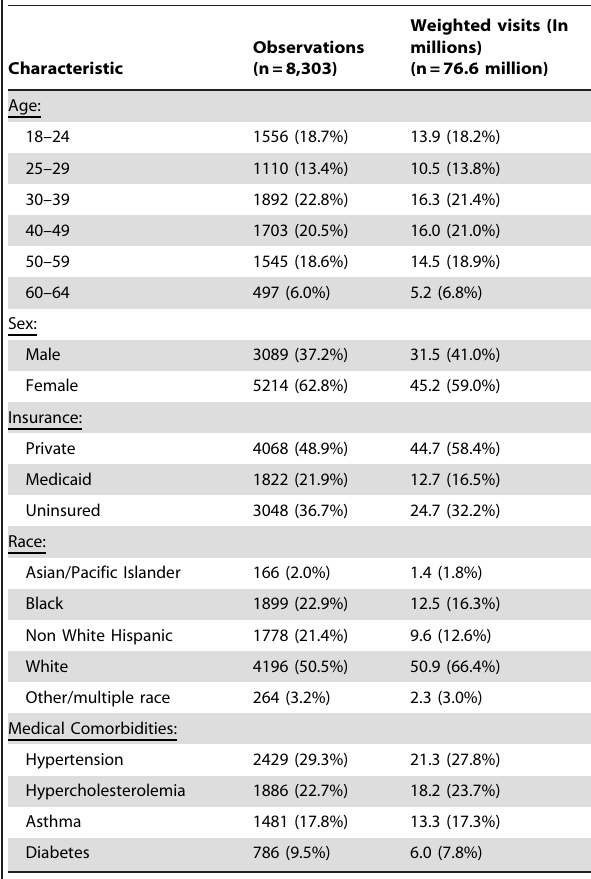
Table 1. Patient demographics.